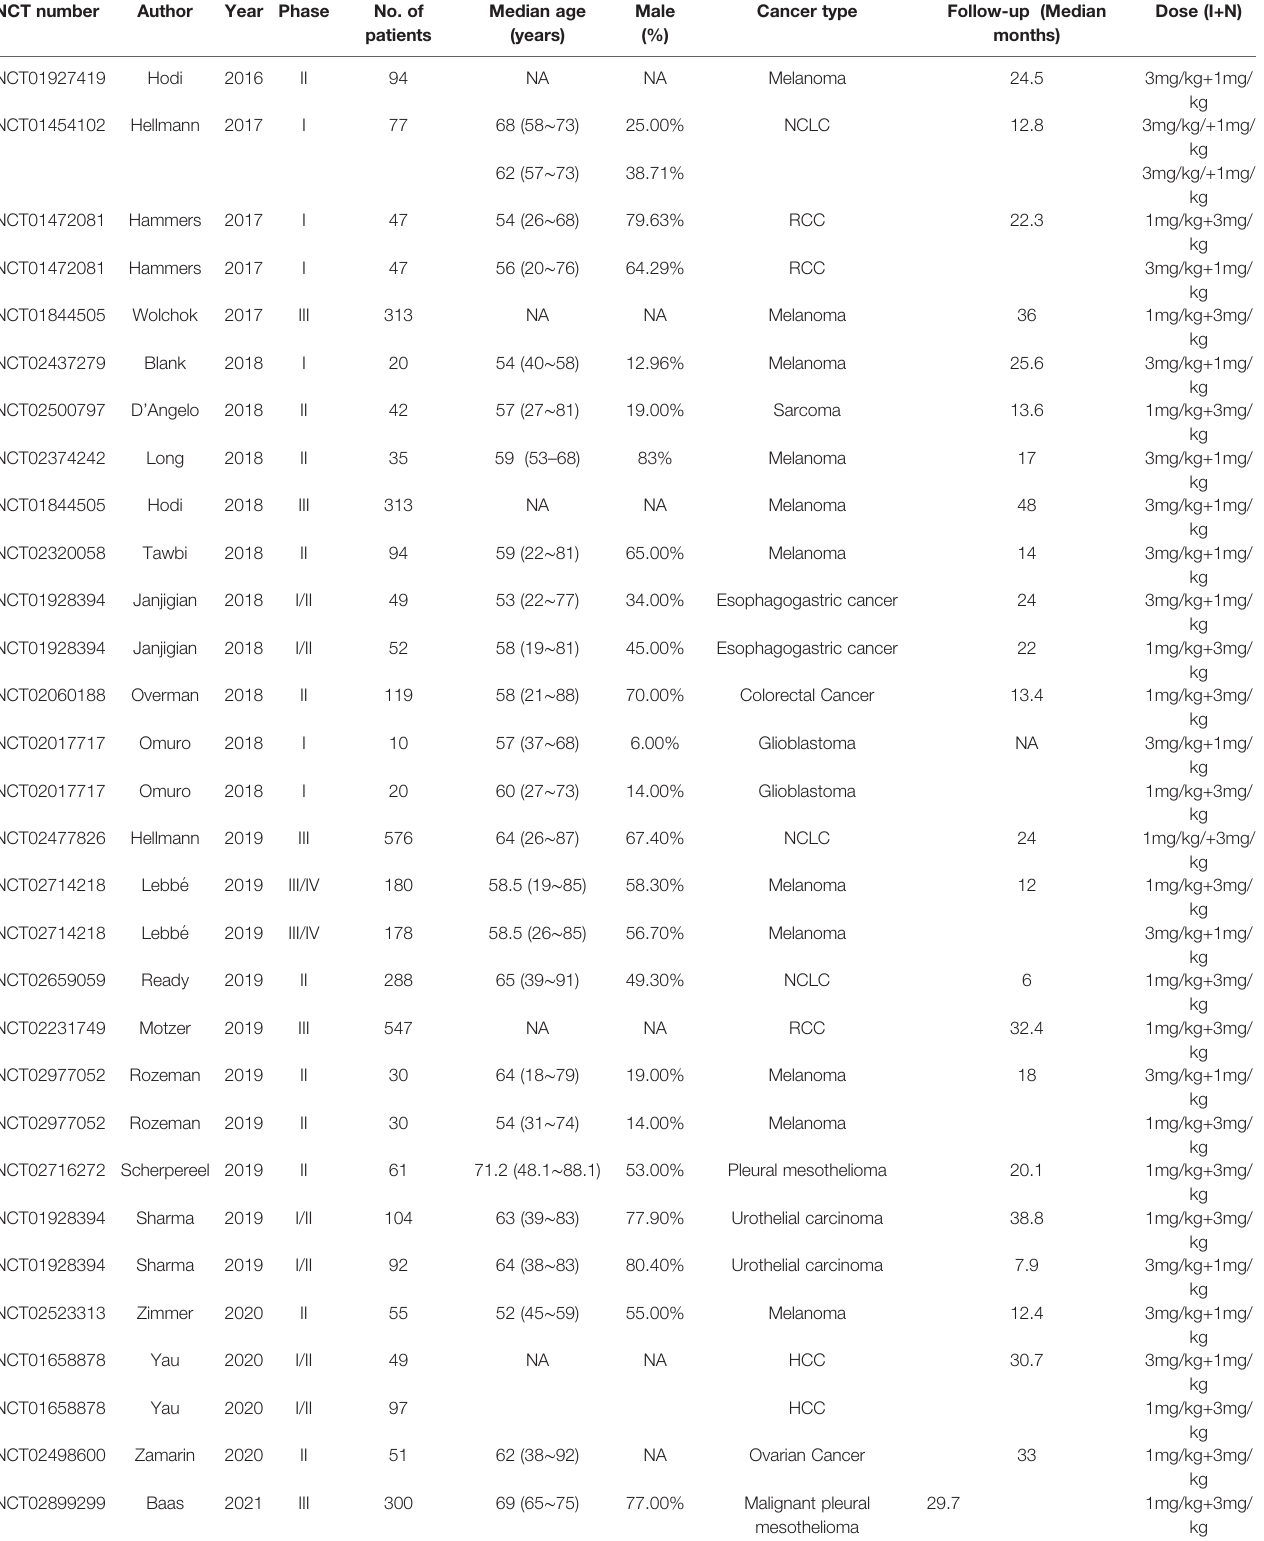
TABLE 1 | Characteristics of the included